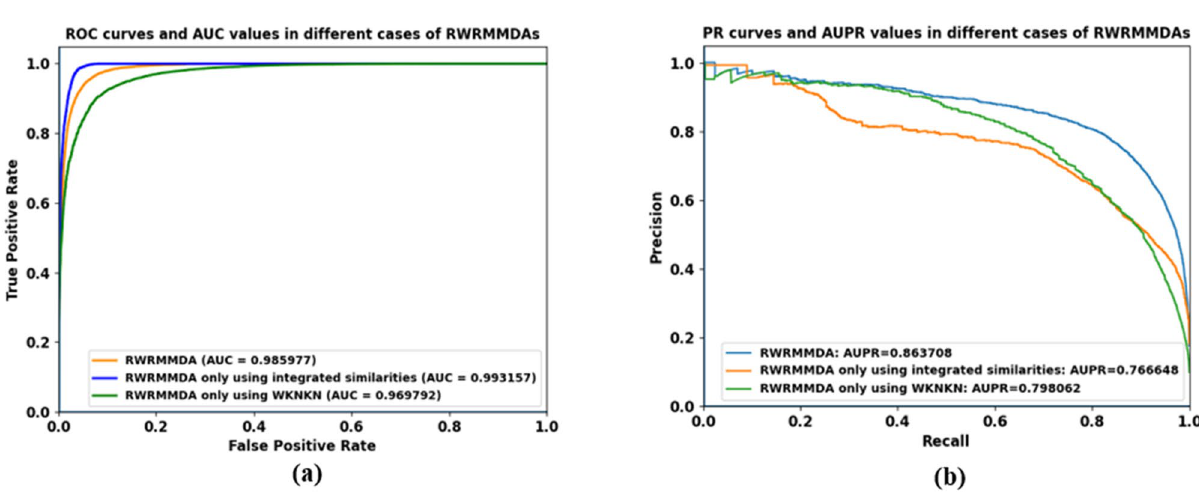
Figure 8. ROC curves and AUC values ( a ) and precision-recall curves and AUPR values ( b ) in different cases of